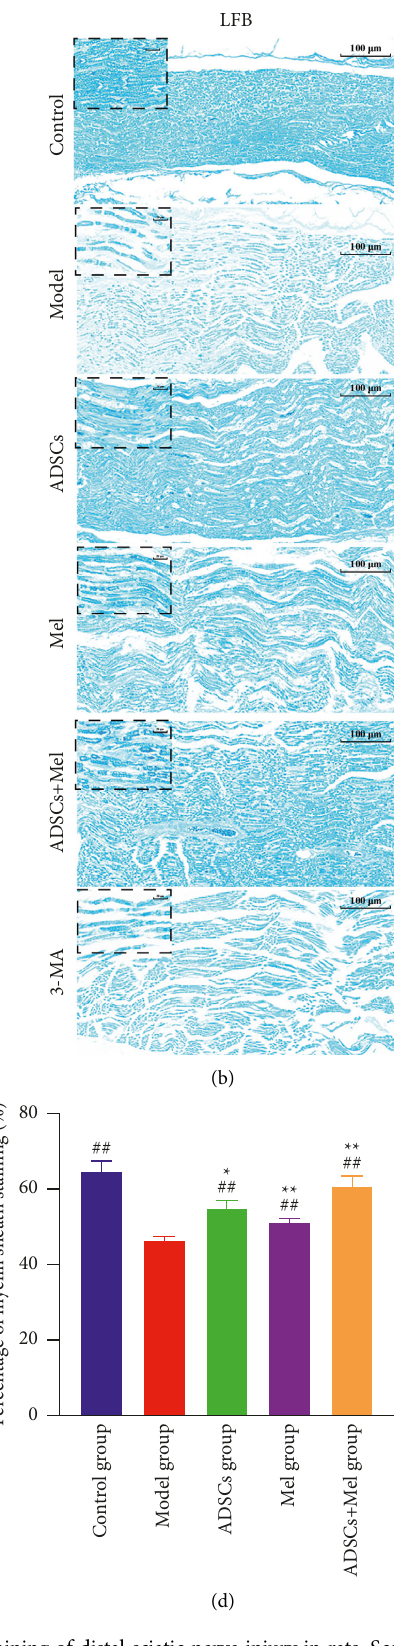
Figure 10: The structure of sciatic nerve in different groups. (a) TEM staining of distal sciatic nerve injury in rats. Scale bar � 10 μ m. (b) LFB staining of distal sciatic nerve injury in rats. Scale bar � 100 μ m. (c) Myelin sheath thickness in each group. (d) Percentage of myelinsheath staining. Thecontrolgroup,ADSCsgroup,Melgroup,ADSCs+Melgroup,and3-MAgroupwerecomparedwiththemodelgroup,respectively.Eachvalue isthemean ± SEoffiveindependentdeterminations. ## P < 0 . 01 and # p < 0 . 05,comparedwiththemodelthegroup; ∗∗ p < 0 . 05,thecontrolgroup, ADSCs group, model group, Mel group, ADSCs+Mel group, and 3-MA group were compared with the ADSCs+Mel